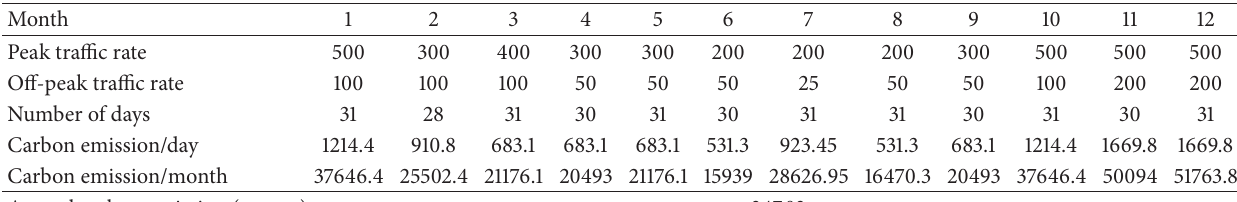
Table 10: Overall carbon emission per annum.